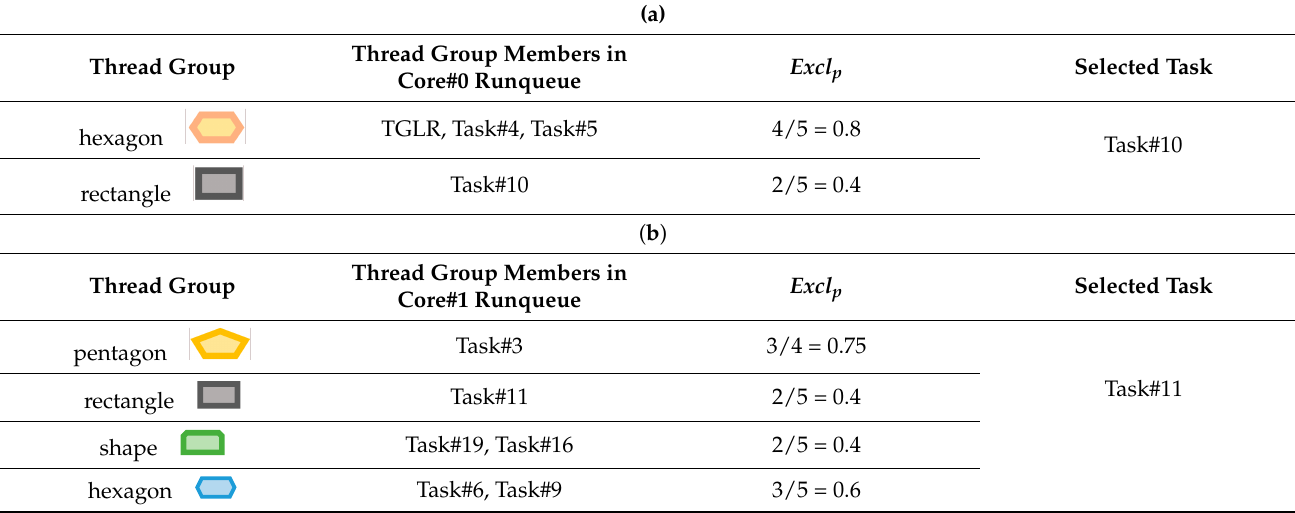
Table 3. The evaluation of the Exclusivity policy. ( a ) The evaluation for tasks in Figure 9; ( b ) The evaluation for tasks in Figure 7.